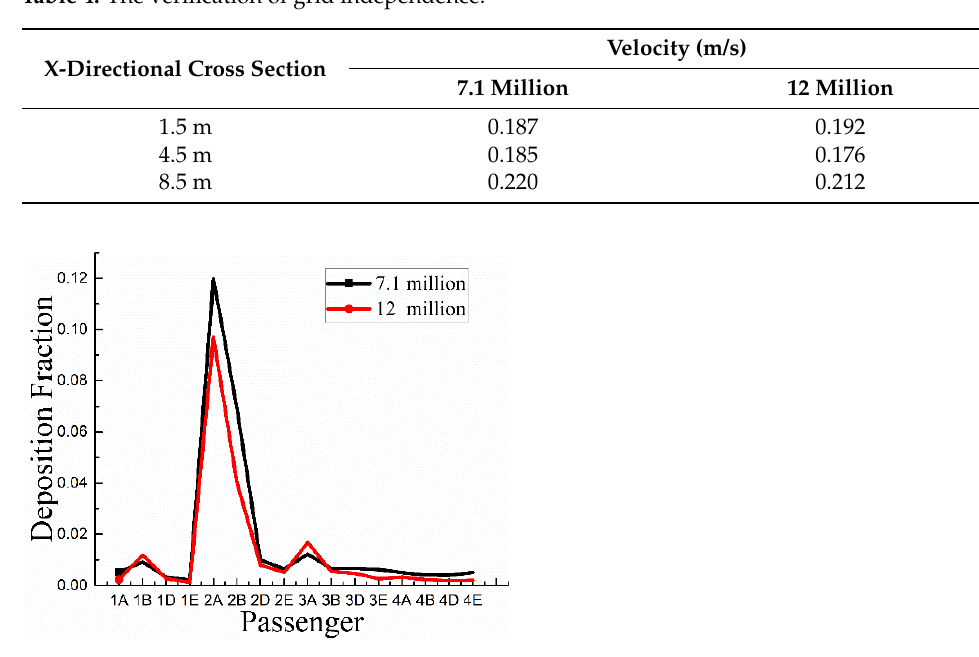
Figure 6. The test chamber diagram, point 1 is the measurement location.